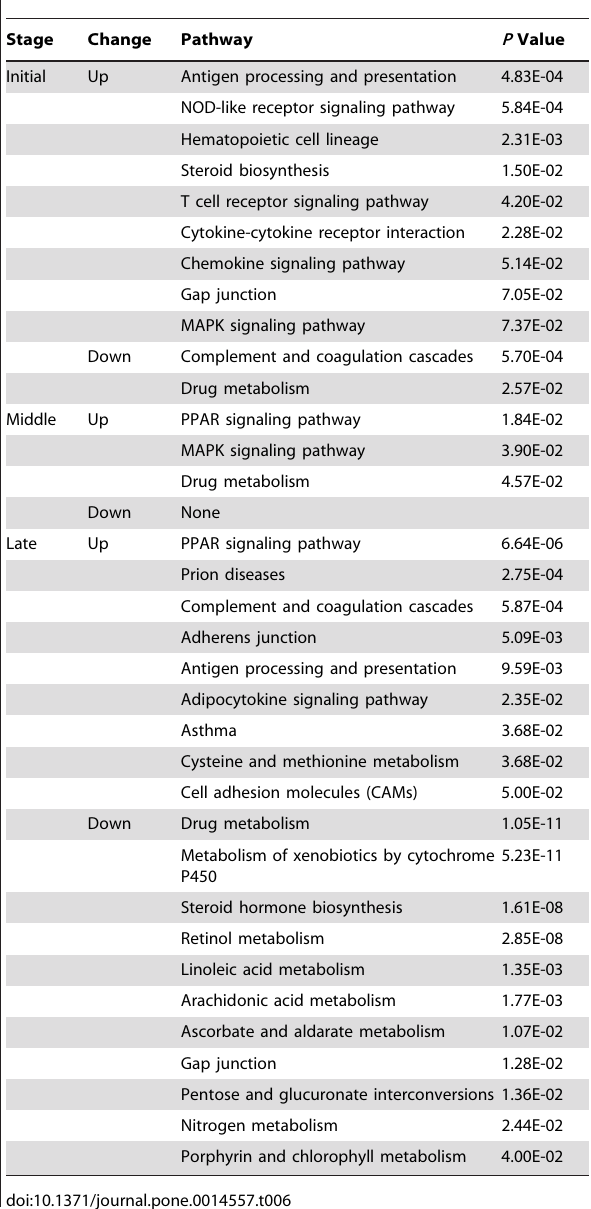
Table 6. Pathways enriched with differentially expressed genes during all three stages of E. multilocularis infection in experimental mice: initial (1 and 2 months), middle (3 months) and late (6 months)